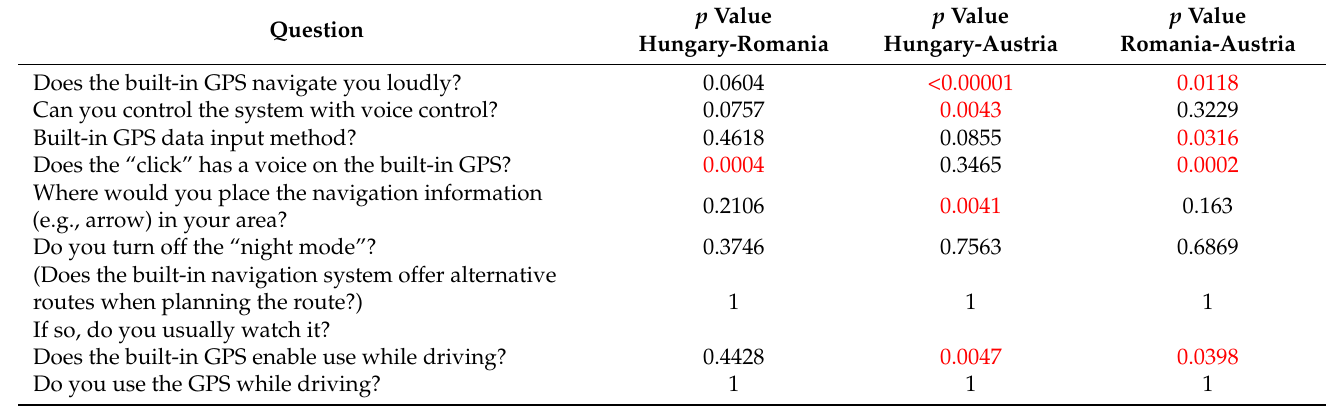
Table 5. Results of the Fisher’s exact test. Significant differences ( p < 0.05) in